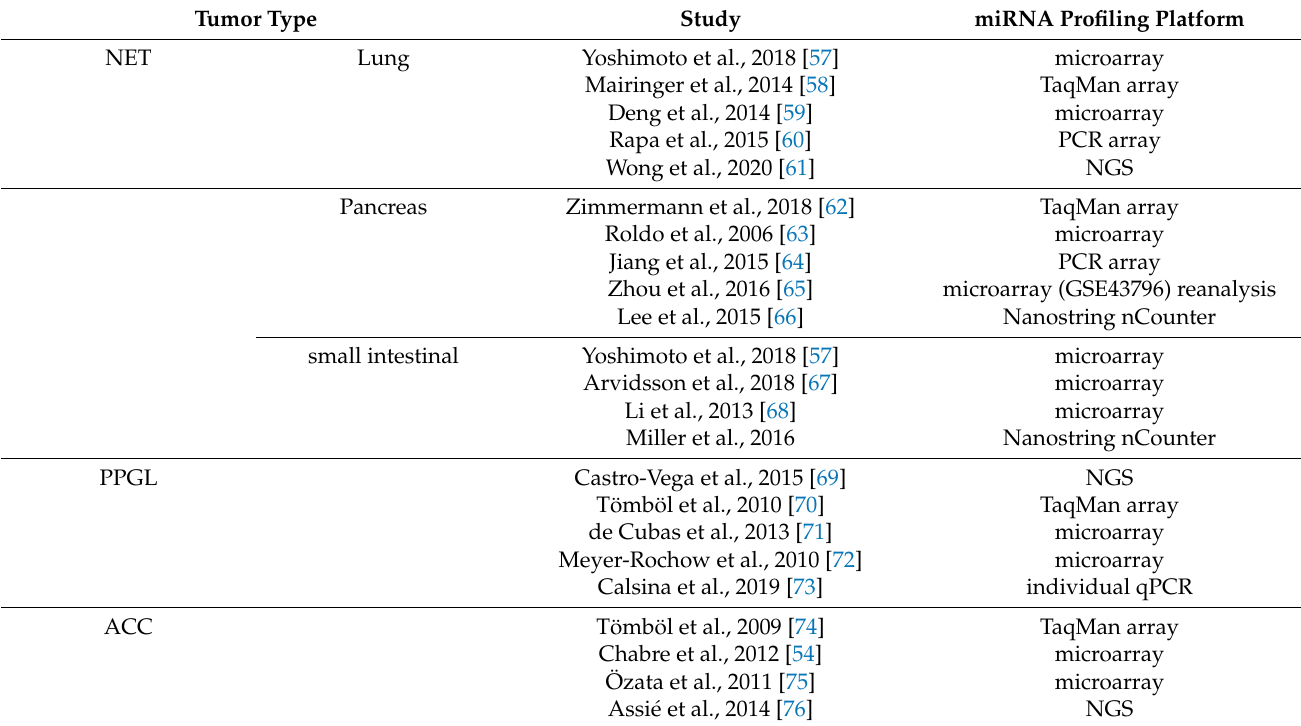
Table 1. MiRNA studies used for heatmap